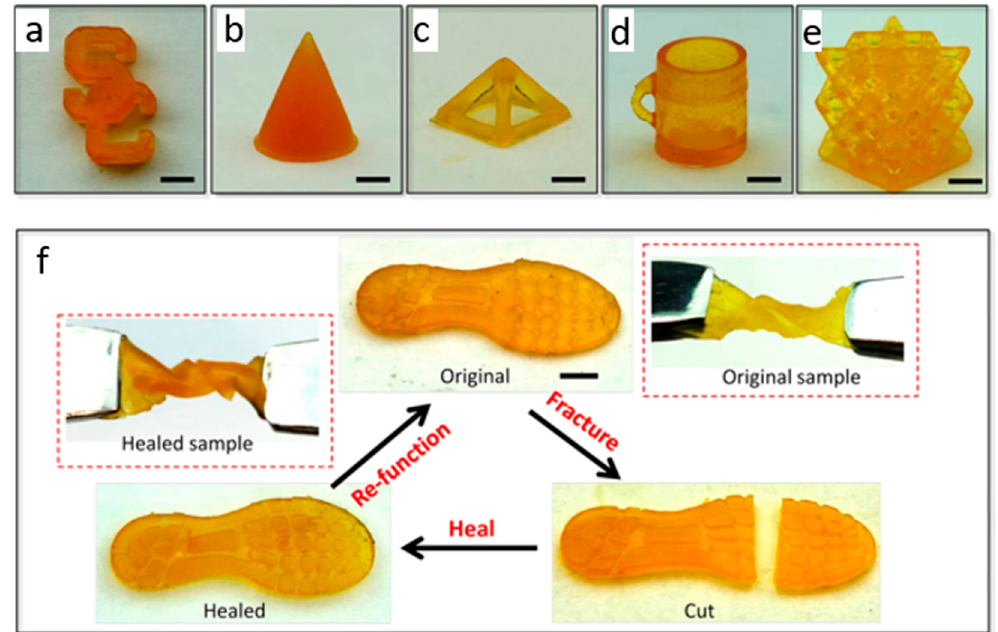
Figure 16. Manufacturing samples used to test self-healing mechanism with using shoe pad sample. ( a ) A logo of the South California University, ( b ) circular cone, ( c ) pyramid lattice, ( d ) cup, and ( e ) an octet truss lattice. ( f ) Self-healing of a shoes pad sample. (Reprinted with permission from [61].